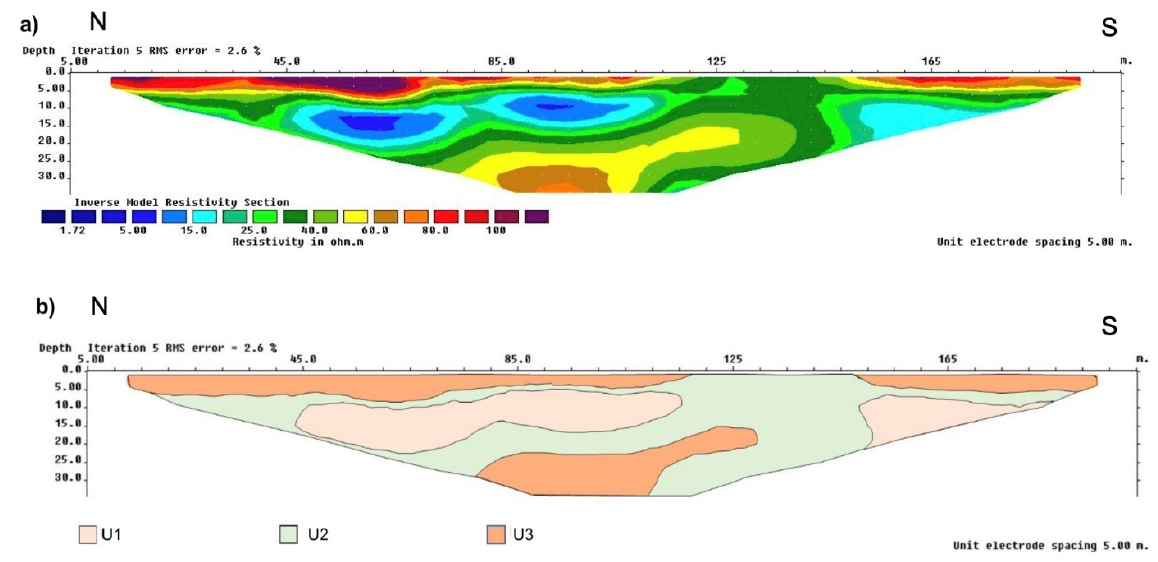
Figure 4. 2D tomography of the selected site in previous studies, which could no longer be used for the stormwater park because the site was developed. However, this analysis was useful because it provides a general sense of soil characteristics of adjacent areas. Top figure, (a) Resistivity profile - red and purple zones are highly compacted, while green and blue zones are suitable for infiltration. Bottom figure (b) Geoelectric unity profile - unit 1 represents low-resistivity materials like clays, unit 2 is sand with a good capacity for infiltration, and unit 3 is highly compacted, which makes infiltration difficult (credit: B. González-Méndez and J. Valencia-Sauceda). For this study, a team of soil scientists and IMPLAN officials identified a new area for the stormwater park (22 ha) (Figure 3) and conducted a soil assessment using a sys- tematic sampling (red points in Figure 3) with an irregular grid of about 200 m × 200 m. At each quadrant, soil was drilled up to 80 cm deep with the help of a Pürckhauer gouge auger (a tool used for profiling in hard soils). Because there were homogeneous soils in the study area, the team developed a soil profile [59]. From each soil horizon, three soil cores were taken to determine the bulk den- sity, an indicator of compaction. Additionally, following the standard procedure for soil sample analysis—the team took samples from each horizon, put them in a paper bag, air- dried in the laboratory and sieved to pass 2 mm. To assess the physical and chemical properties of the soil samples, the team measured the pH and electrical conductivity (EC) (in water 1:2.5, Horiba F74BW), soil texture (Bouyoucos), bulk density (soil cores), total C and N (TOC, Perkin Elmer, 2400), cationic exchange capacity (CEC, extraction, AAS Per- kin Elmer 900 HK), and total metals concentration (X-ray fluorescence spectrometer, XRF, Niton XL3 Ultra). Finally, the team experimented with soil enhancement techniques using biochar. 2.7. Landscape Design for a Stormwater Park in the Green Belt of Hermosillo The primary goal of this project was to design a large urban park to accommodate the increase in new low-income housing development in the northwest of Hermosillo and with soil conditions suitable for stormwater infiltration and plant establishment. The se- lected site is surrounded by low desert scrub, arroyos (ephemeral natural drainages), and two mountains. There is a mountain to the north and the other to the west, known as the Mountain of Black Rocks, including the Cerro Colorado. The city planners of Hermosillo aim to preserve as much as possible of the natural watercourse because of flooding threats